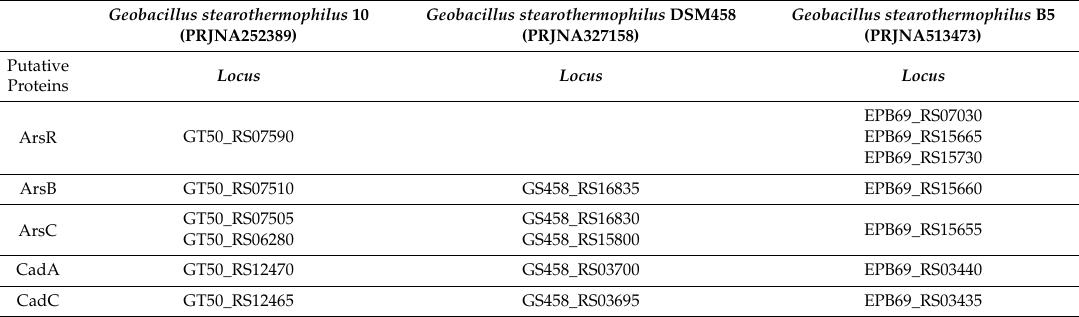
Table 3. List of putative genes for As and Cd(II) resistance in G. stearothermophilus